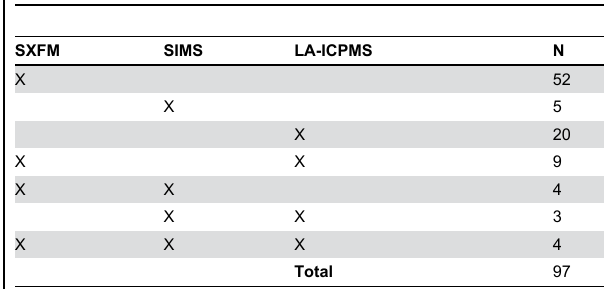
Table 1. Numbers of individual fish used for different otolith chemistry analyses.